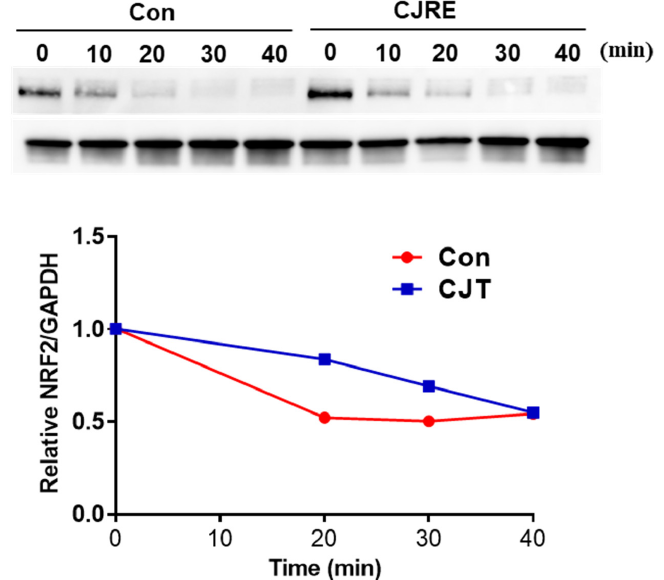
Figure 4. CJRE enhanced the NRF2 stability in HeLa cells. Cells were treated with CJRE (100 µg/mL) for 24 h and followed CHX (5 µg/mL) treatment for different time points. Next, the collected lysates were subjected to Western blotting. After densitometric analysis, the relative NRF2/GAPDH amounts were indicated in the graph (bottom